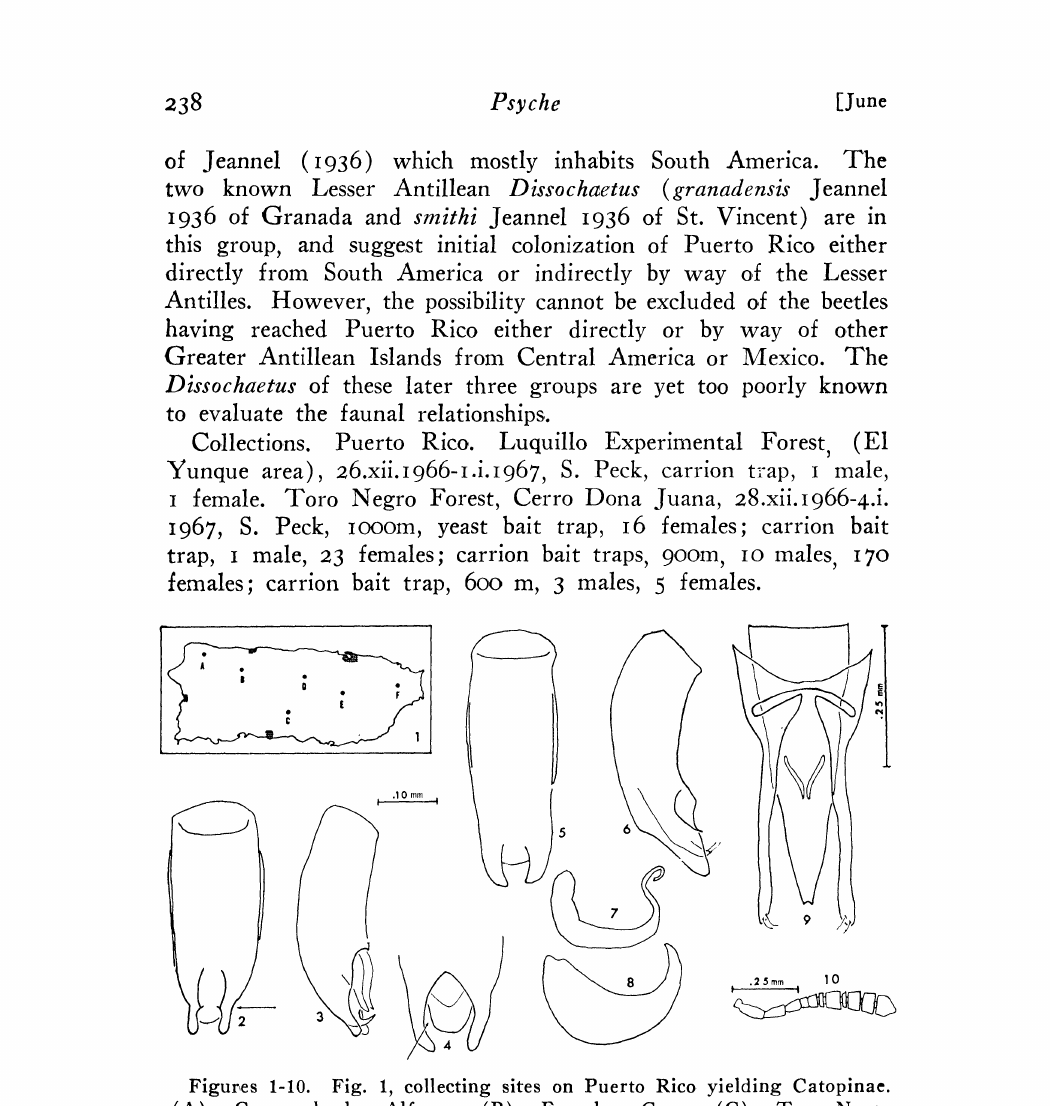
Figur,es 1-10. Fig. 1, collecting sites on Puerto Rico. yielding Catopinae. (A). Cueva de los Alfaros. (B). Empalme Cave. (C). Toro Negro Forest. (D). Cueva de Corozal. (E). Aguas Buenas Cave. (F). Luquillo Forest, (El Yunque). Fig. 2, dorsal surface aedeagus P’roptomaphaginus darlingtoni. Fig. 3, lateral surface aedeagus P. darl.ngtoni. Fig. 4, dorsal surface of tip of aedeagus P. atodemus. Fig. 5, dorsal surface aedeagus P. luertoricensis, Fig. 6, lateral surface aedeagus P. luertoricensis. Fig. 7, spermatheca of P. luertorfcensis. Fig. 8, spermatheca o.f P. apod’emus. Fig. 9, dorsal surface aedeagus Dissochaetus portoricensis. Fig. 10, antenna P.